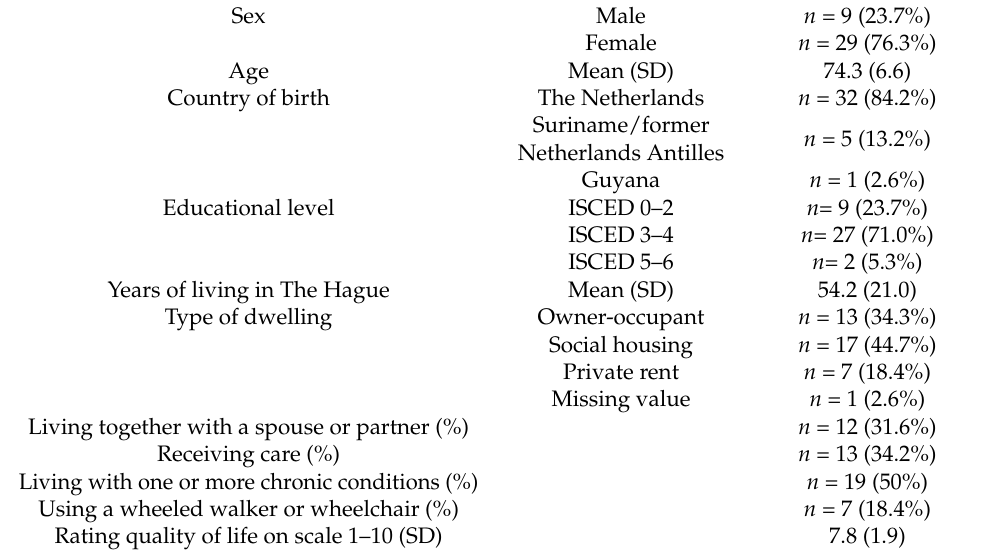
Table 2. Demographic data of the participants ( n = 38).